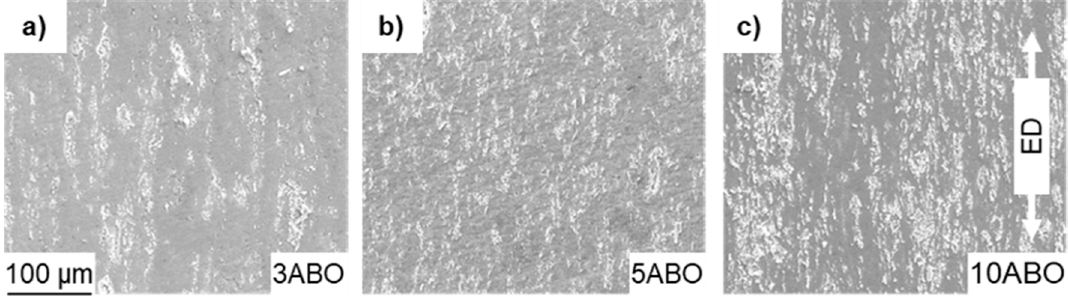
Figure 8. SEM micrographs of the as-annealed: ( a ) 3ABO composite; ( b ) 5ABO composite; and ( c ) 10ABO composite